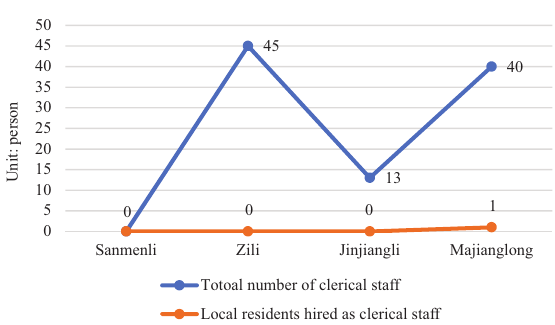
Figure 8. Total number of clerical staff and local residents hired as clerical staff (source: field survey)